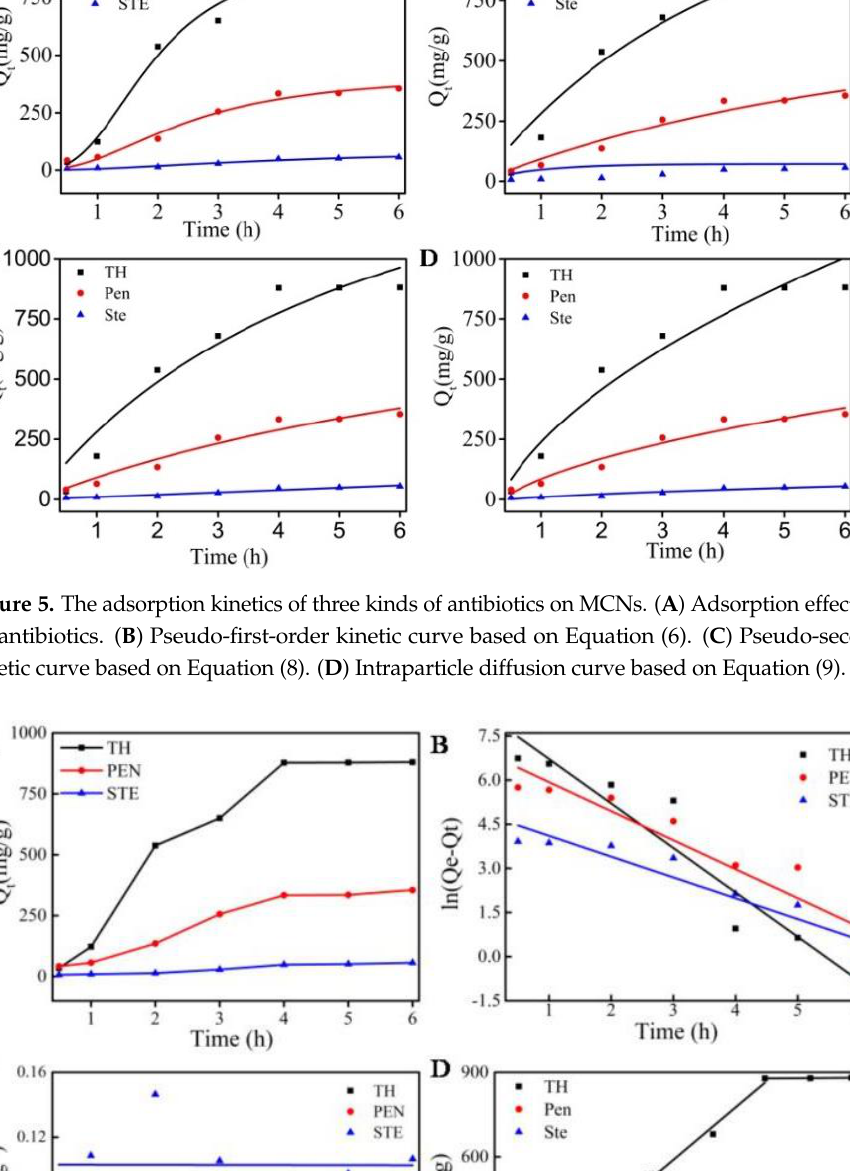
Figure 6. The adsorption kinetics of three kinds of antibiotics on MCNs with linearity. ( A ) Adsorption effect of MCNs on antibiotics. ( B ) Pseudo-first-order kinetic curve. ( C ) Pseudo-second-order kinetic curve. ( D ) Intraparticle diffusion curve. Table 2. The adsorption kinetic parameters of three antibiotics on MCNs.